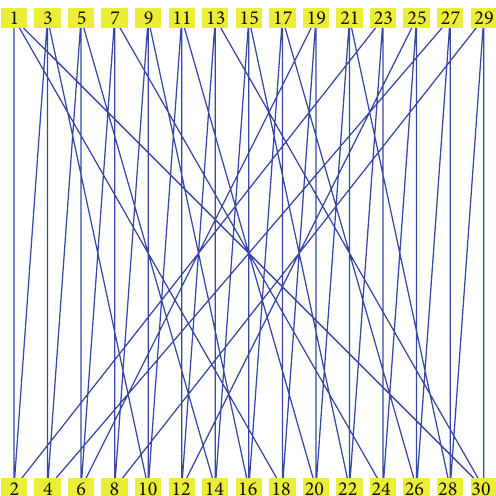
Figure 5: Levi graph: bipartite style.